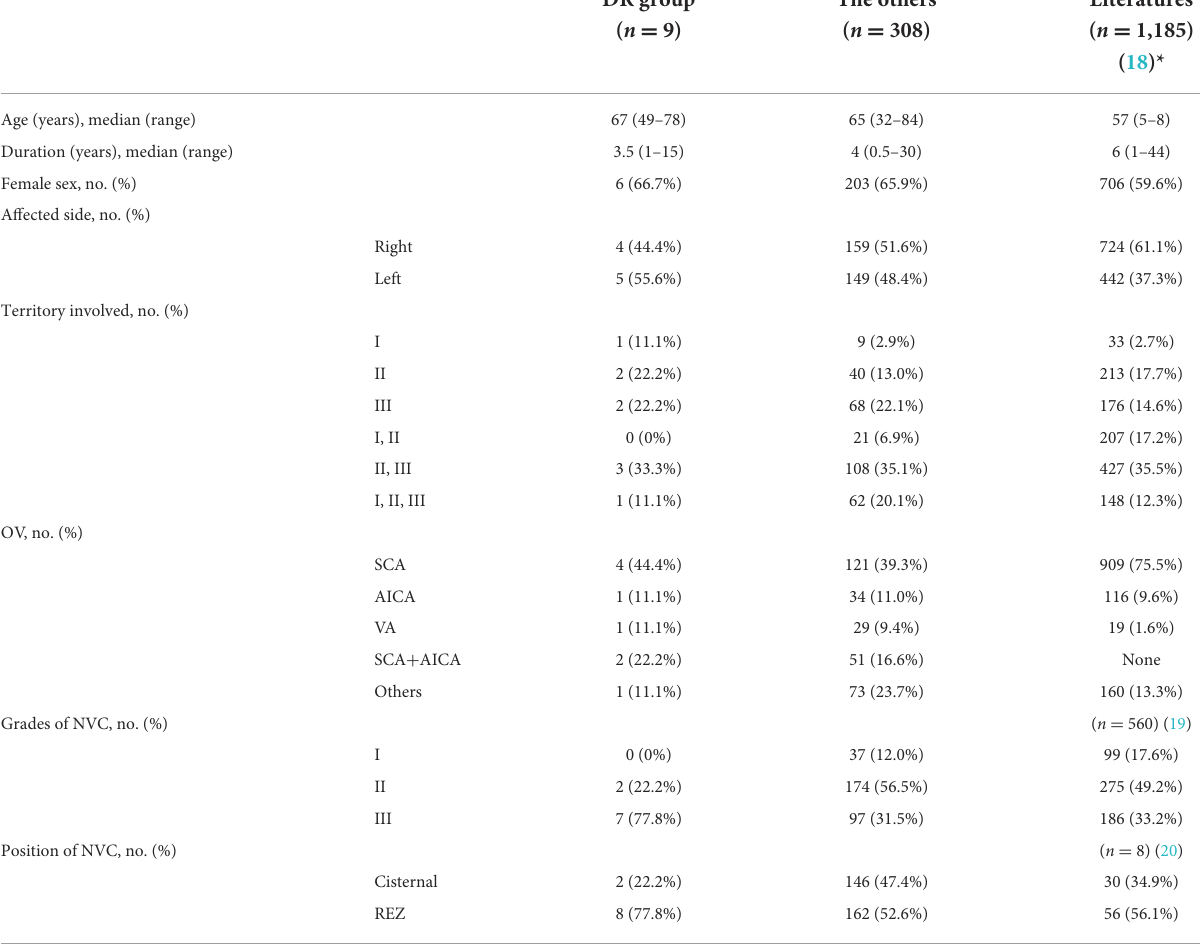
TABLE 2 General data and intraoperative findings of DR patients and literature